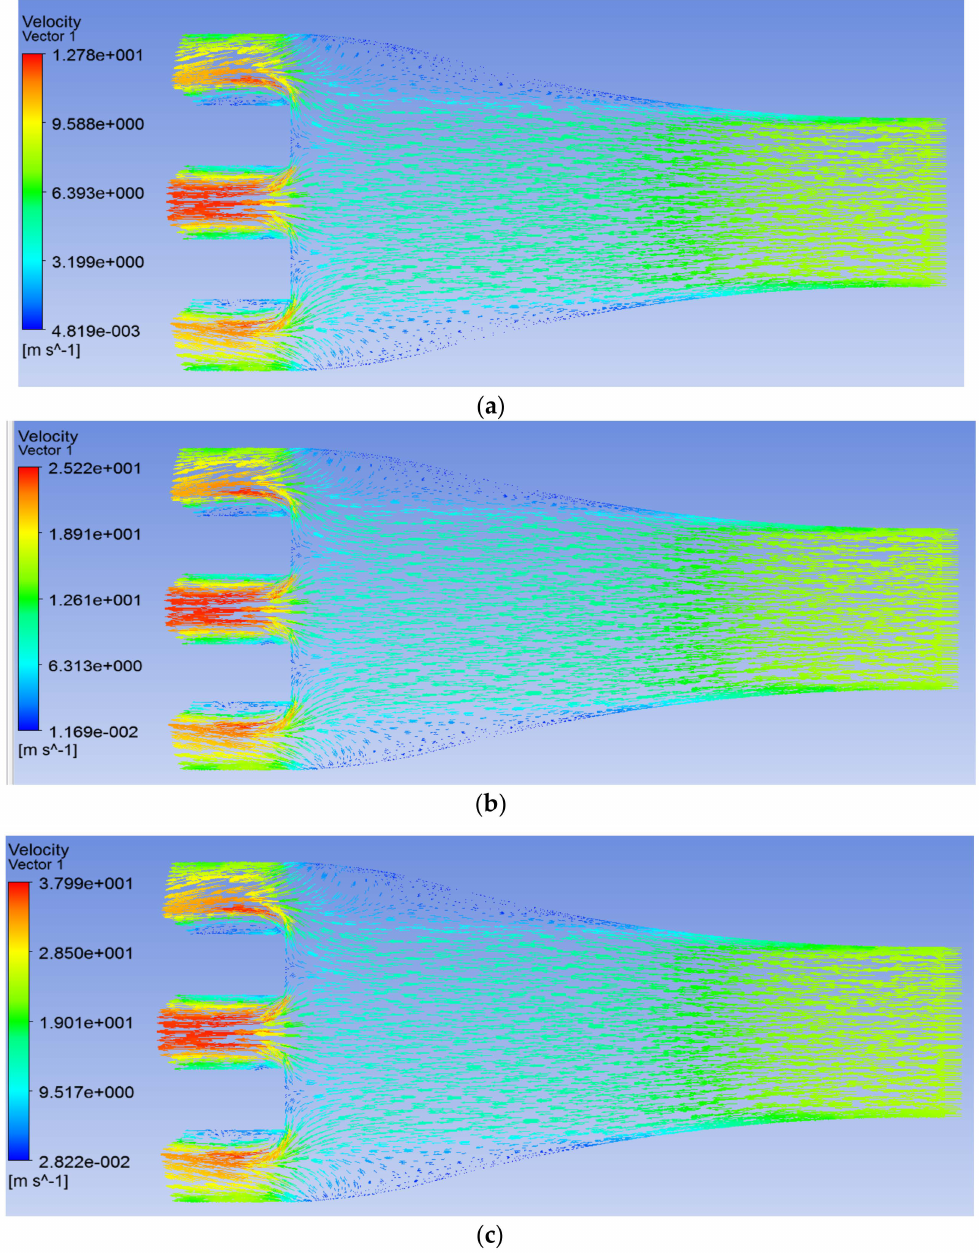
Figure 13. The velocity flow field distribution of different rice distributor CFD simulation with type